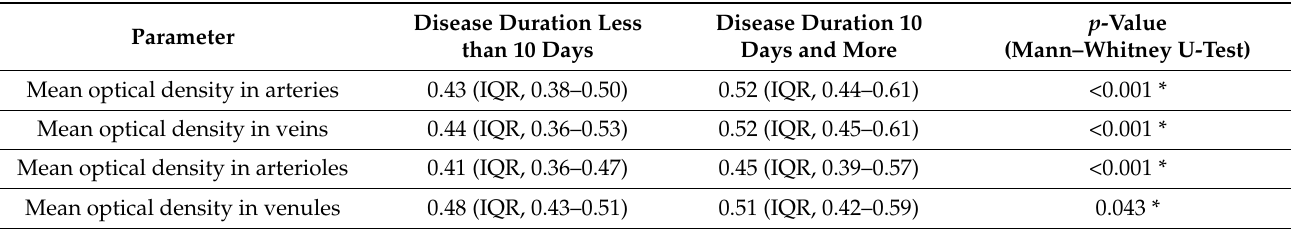
Table 2. Comparative intergroup analysis of mean optical density in pulmonary vascular endothelium in groups of patients with duration of disease more/less than 10 days.